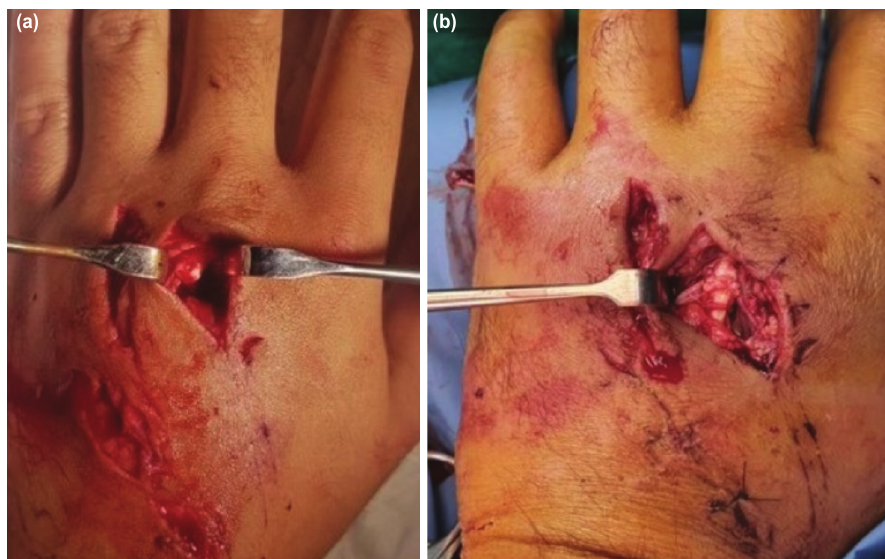
Extensor tendon injury. (a) Shows transected EDC of the left middle finger. (b) Shows the repair prior to the placement of the Fig. 3: epitendinous suture.